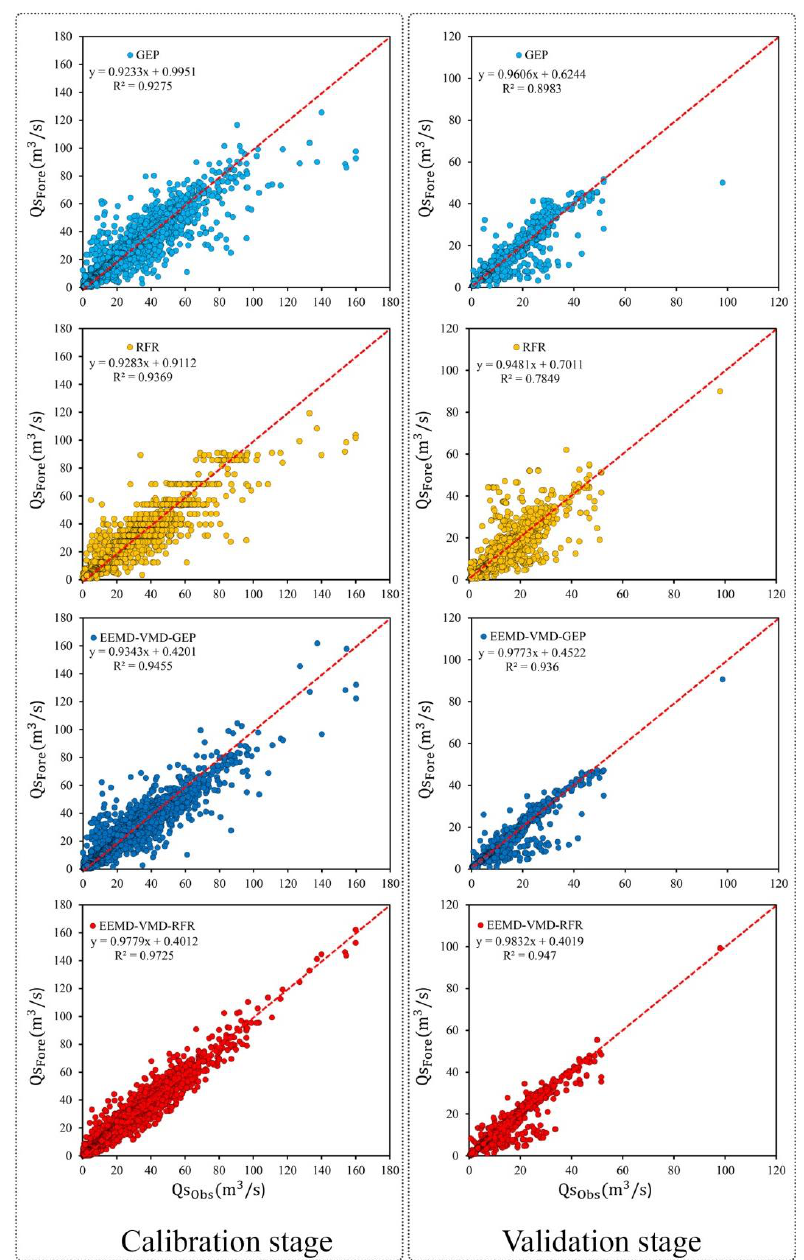
Figure 7. Scatterplot of forecasted (Qs) and observed (Qs) river flow using the standalone GEP, RFR, and ensemble EEMD-VMD-GEP, EEMD-VMD-RFR models for the calibration and validation stages at the Siira station.